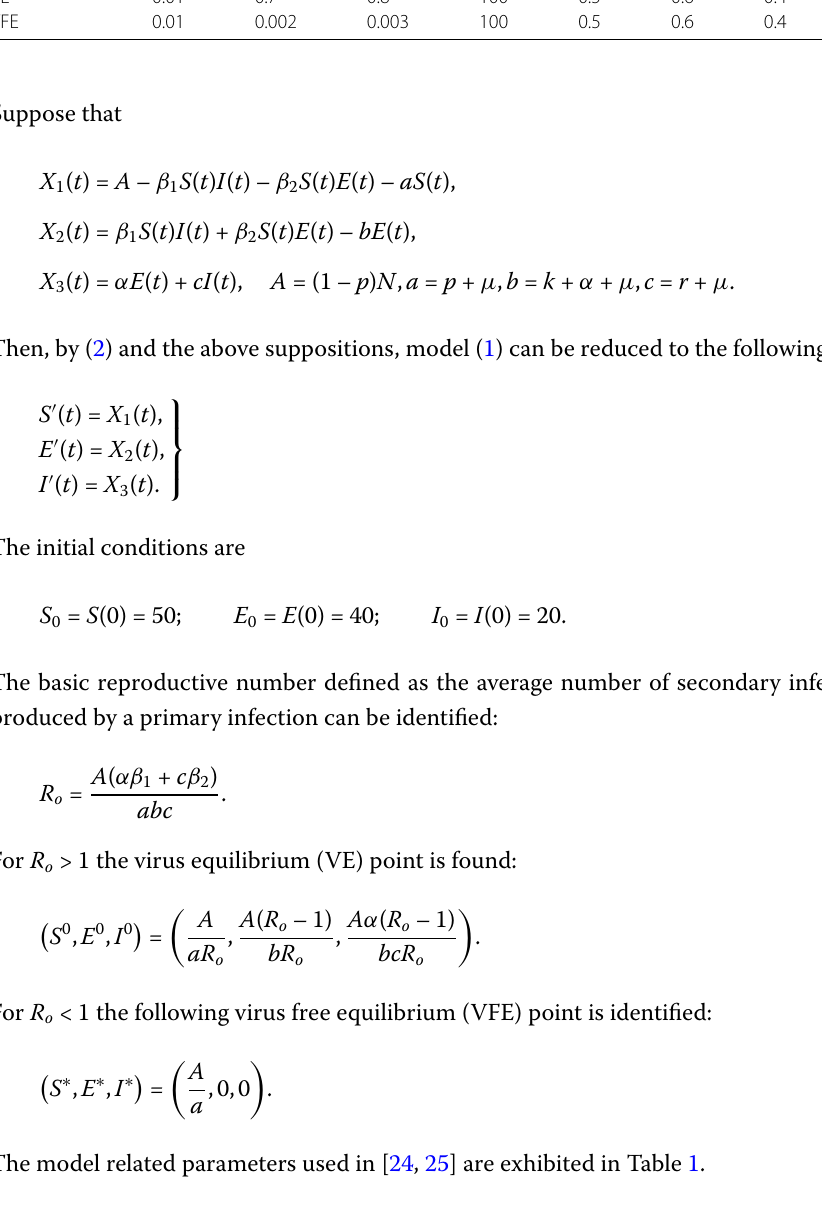
Table 1 Values of the model parameters for two points of equilibriums Equilibrium Model parameters point α β 1 β 1 N p r